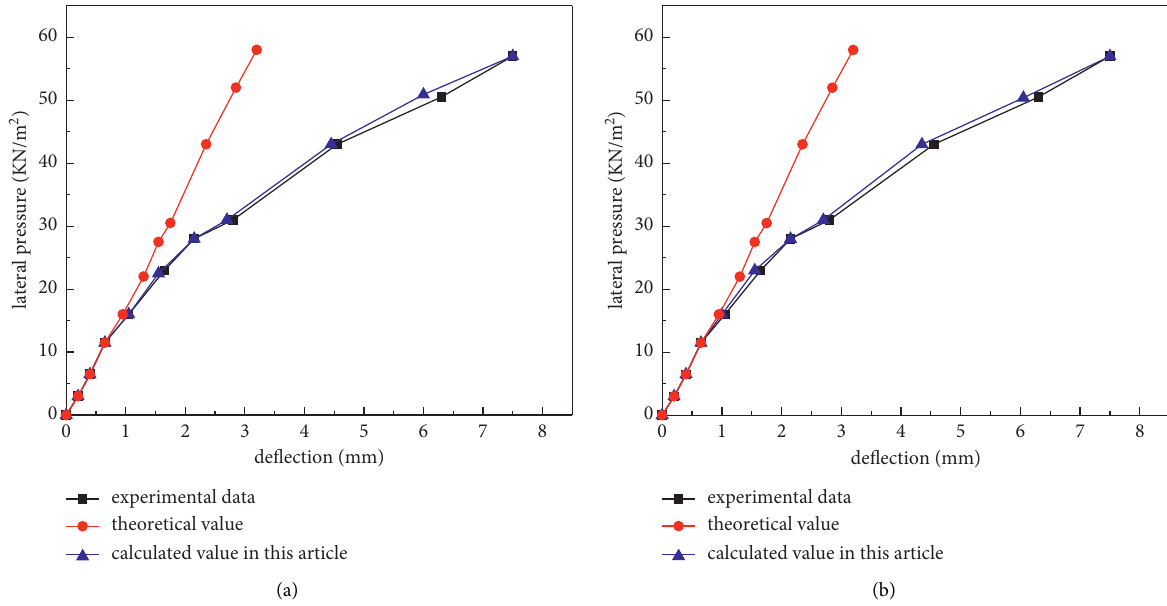
Figure 11: Comparison of deflection values and deflection test values of wall panels under various loads. (a) Inner wall. (b) Outer